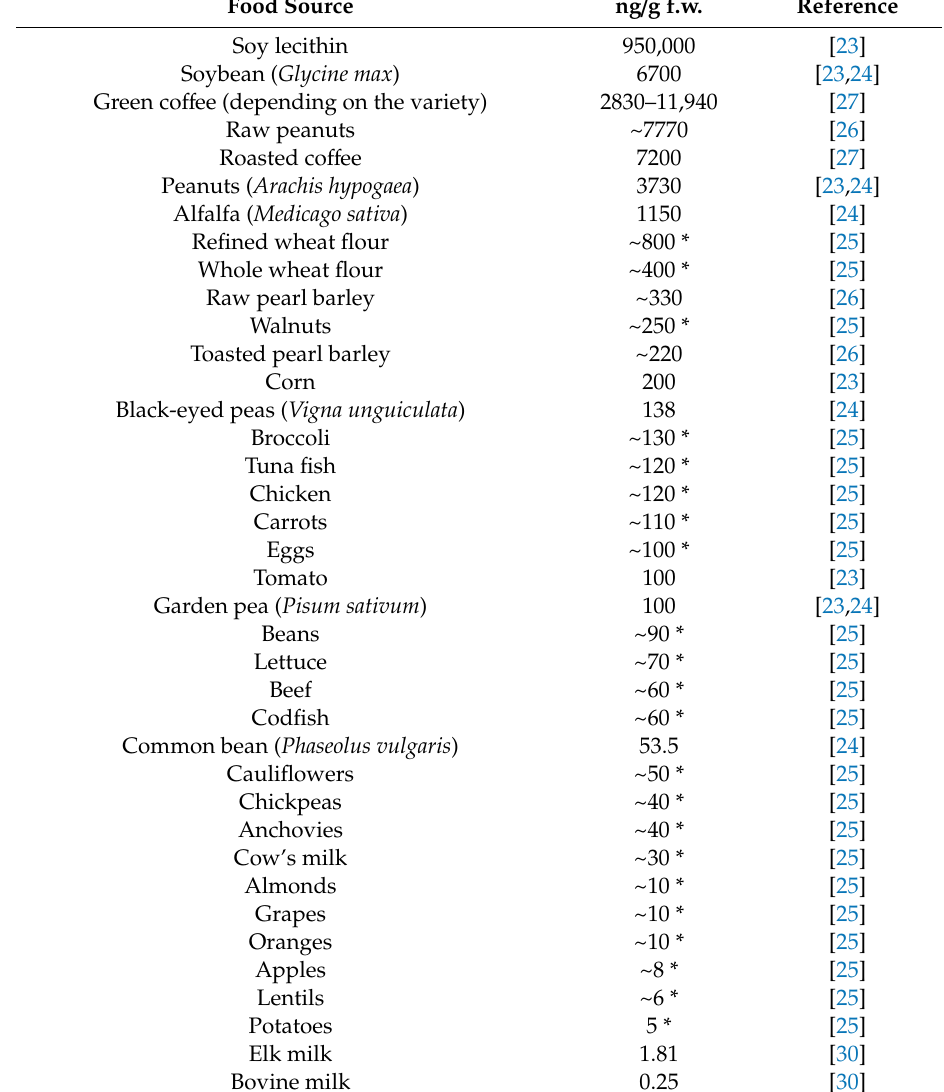
Table 1. Food sources in order of decreasing concentration of palmitoyl ethanolamide